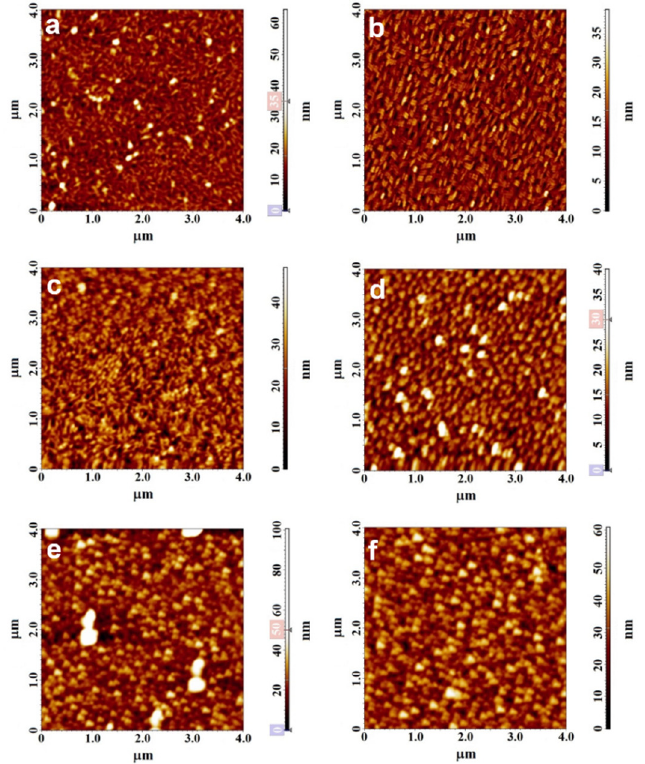
Figure 4. AFM images of CoPcF 4 -p ( a ), CoPcF 4 -np ( b ), VOPcF 4 -p ( c ), VOPcF 4 -np ( d ), ZnPcF 4 -p ( e ), and ZnPcF 4 -np ( f ) films.